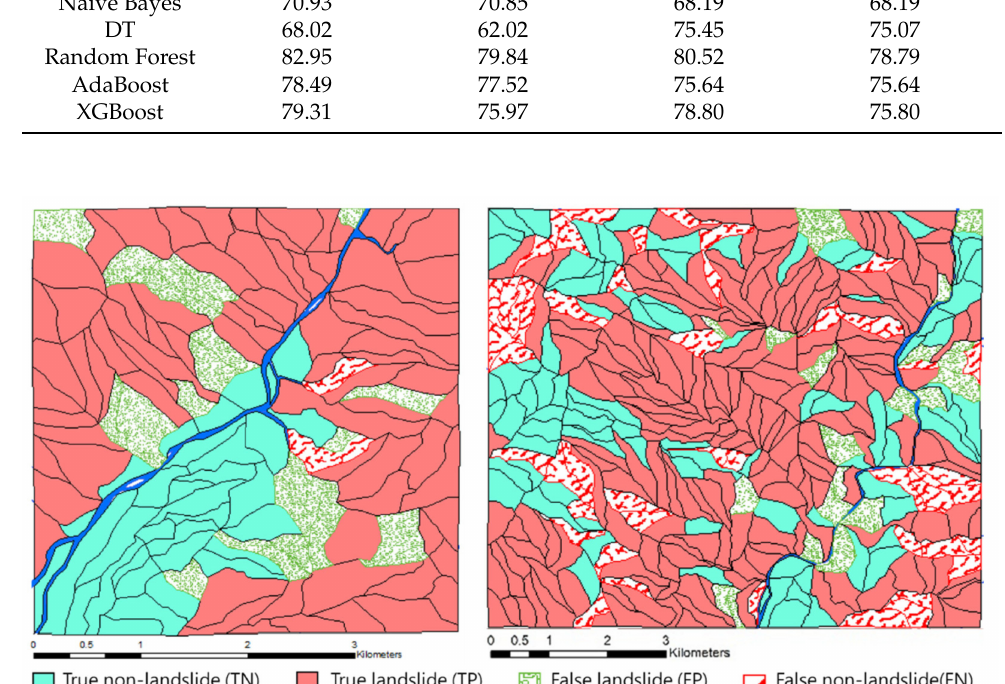
Figure 6. Visual illustration of the landslide prediction results—( left ) Siaolin Village; ( right ) Putun- punas River area.